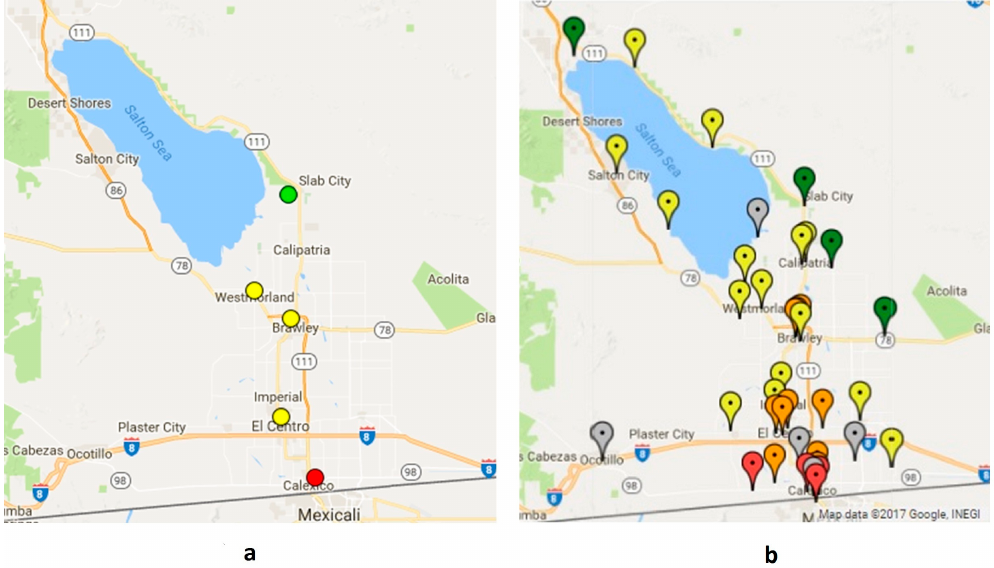
Figure 5. Screenshots of online maps showing air monitor locations and real-time air quality readings taken from ( a ) the regulatory network website and ( b ) the Imperial County CAMN website, on 20 December 2017 [29,30]. For both maps, the color of the monitor markers correspond to health risk related to current air quality conditions, where green is lowest risk, yellow is moderate risk, orange is unhealthy for sensitive populations, and red is unhealthy. Gray markers on the CAMN map indicate monitors that are offline.